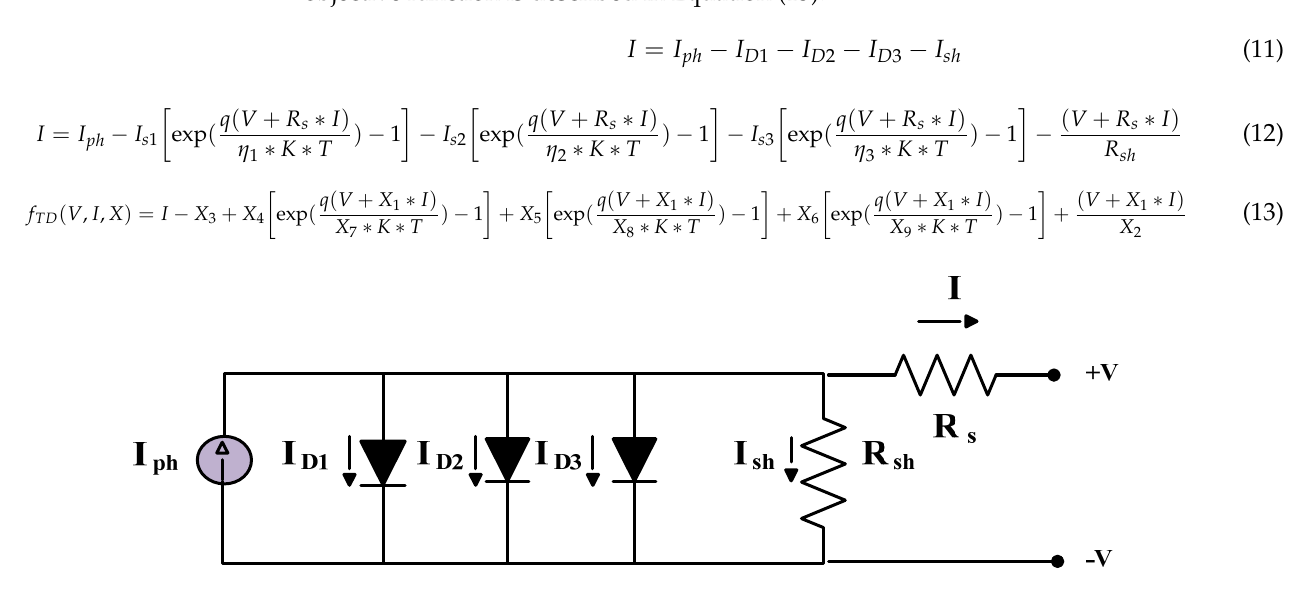
Figure 5. The TDM.